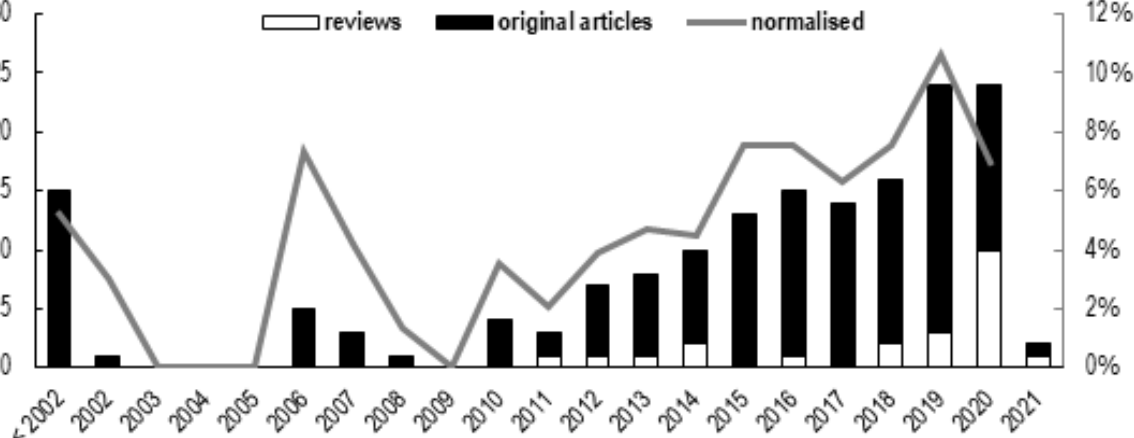
Figure 3. Time distribution of the original studies selected for this scoping review (black), and reviews (white), ordered by publication year. The graph also reports the number of original articles published, normalised (%) to the overall number of manuscripts published in the same year in the broader area of sport injury biomechanics, where this quantity was retrieved using the following MeSH term search in PubMed: ((sport[MeSH Terms]) AND (injury[MeSH Terms])) AND (biomechanics[MeSH Terms])).